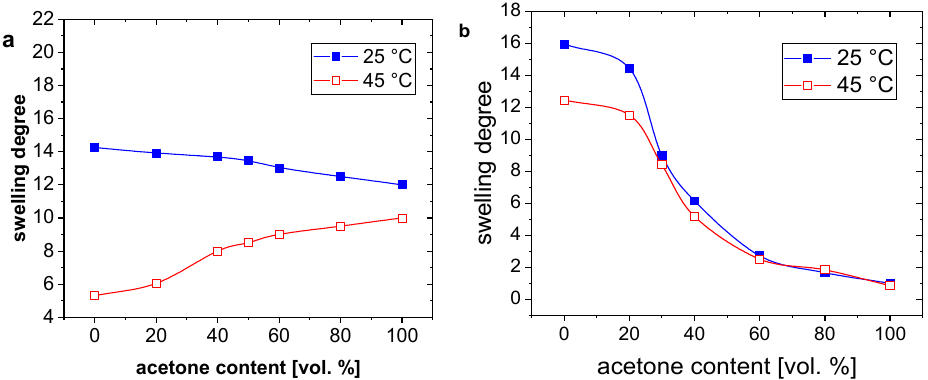
Figure 4. Dependence of the swelling ratio on the acetone content for the SN-D ( a ) and DN-DA ( b ) hydrogels measured at two varying temperatures.